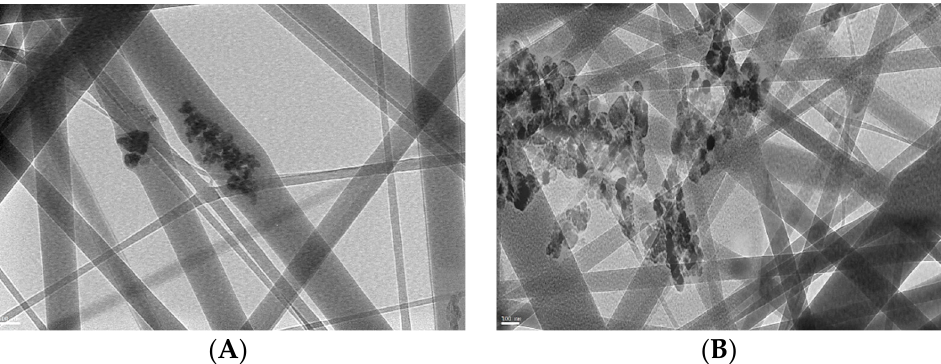
Figure 2. TEM micrographs of ZnO polymeric composite nanofiber ( A ) before silver immobilization and ( B ) after silver immobilization.